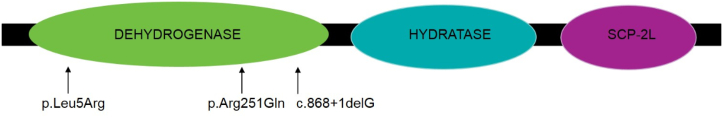
D-Bifunctional Protein structure and mutations. SCP-2 L. C-terminal sterol carrier protein 2-like domain.